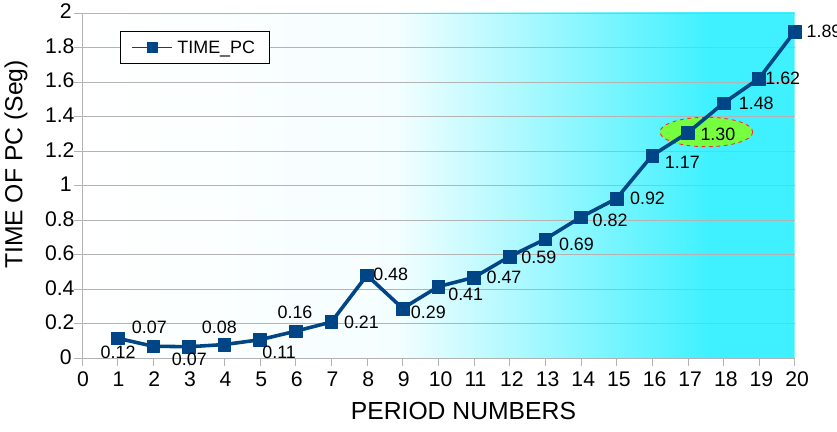
Figure 12. Machine time for a constant number of samples at 32 and varying the number of periods from 1 to